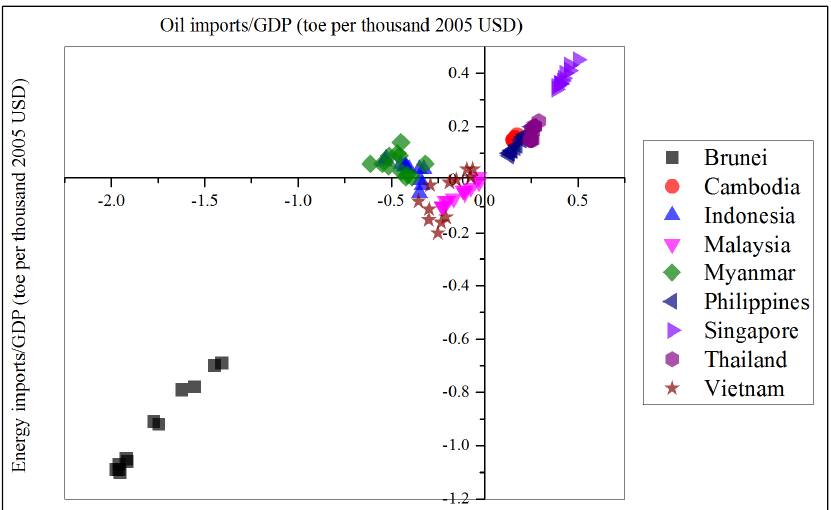
Figure 34. Net imports/GDP between 2001 and 2012.